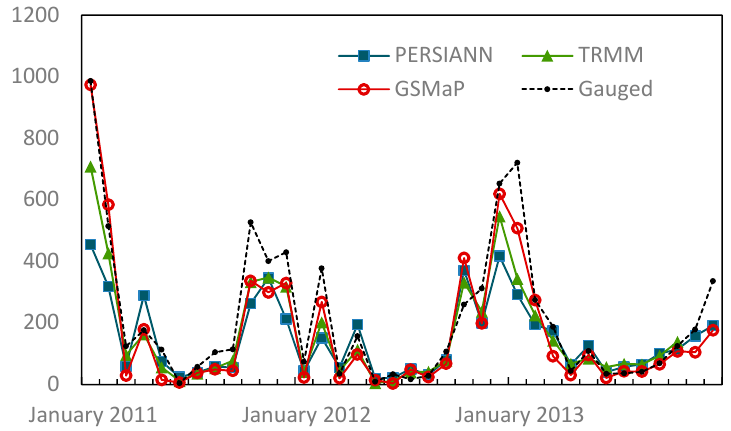
Figure 3. Monthly variation of the SRE values and those of the gauged data.